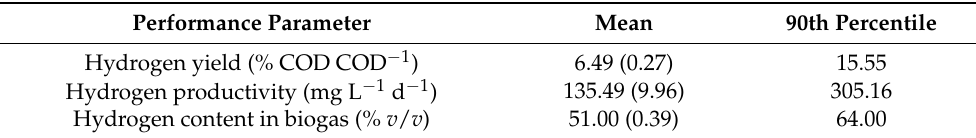
Table 3. Mean, with standard error (in bracket), and 90th percentile values of process performance parameters.